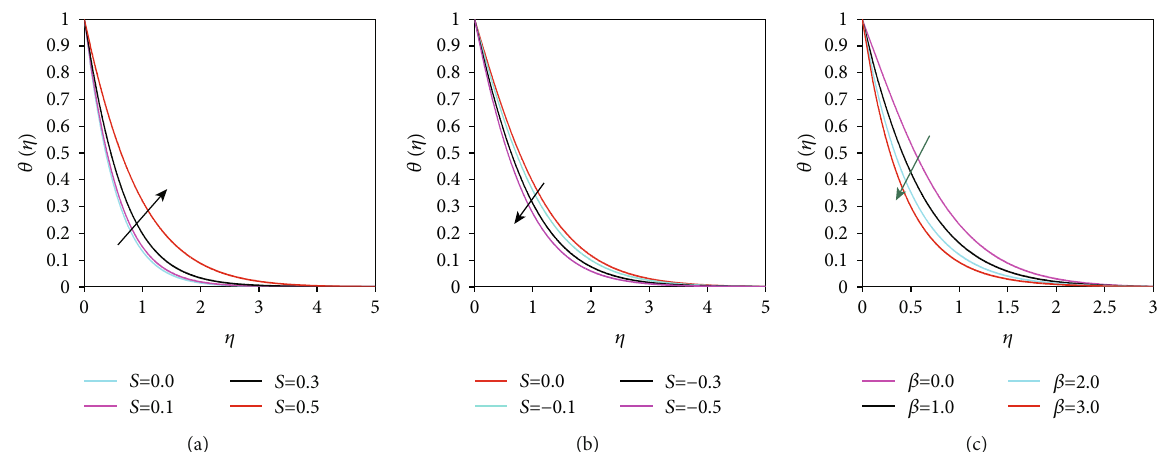
Figure 9: The graph of temperature for di ff erent values of heat source/sink parameter ( S ) and temperature exponent β .